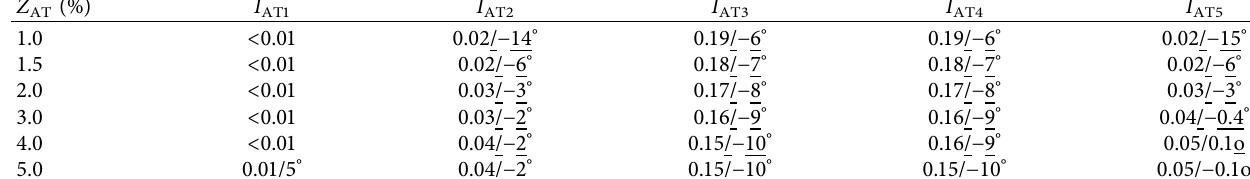
Table 2: Autotransformer currents (in pu) for the example with only one train and real autotransformers. Z AT (%)